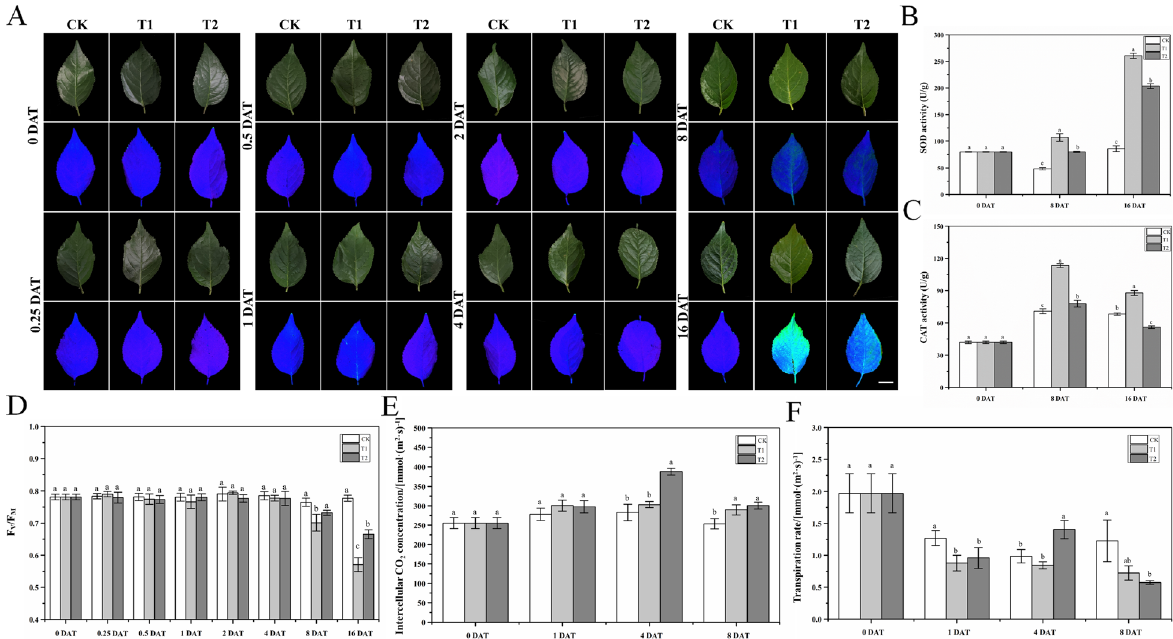
Fig. 5 Changes in chlorophyll fluorescence parameters ( A and D ), antioxidant enzyme activities ( B - C ), and photosynthetic parameters ( E – F ) in ‘G6’ under waterlogging conditions, with or without oxygenation. Changes in chlorophyll fluorescence parameters ( A ) and Fv/Fm ( D ) were measured at 0, 0.25, 0.5, 1, 2, 4, 8 and 16 DAT. Superoxide dismutase (SOD) ( B ) and catalase (CAT) ( C ) activities were measured at 0, 8, and 16 DAT. Intercellular CO 2 concentration ( E ) and transpiration rate ( F ) were measured at 0, 1, 4 and 8 DAT. The data are shown as mean Statistical significance was determined using a one-way ANOVA; significant differences among means (LSD, p < 0.05) are indicated with different lowercase letters. Bar 3 =